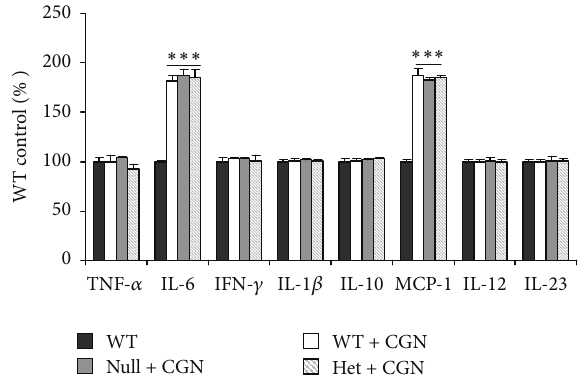
Figure 3: Serum IL-6 and MCP-1 increase post-carrageenan expo- sure, and increases are similar in Bcl10 WT, heterozygous, and null mice. Carrageenan exposure produced significant increases in serum levels of IL-6 and MCP-1 in the WT, heterozygous, and null mice ( 𝑃 < 0.001 ), compared to the unexposed controls. WT, heter- ozygotes, and null mice serum levels of MCP-1 and IL-6 both increased ∼ 85%. Serum levels of TNF- 𝛼 , IFN 𝛾 , IL-1 𝛽 , IL-10, IL-12, and IL-23 did not